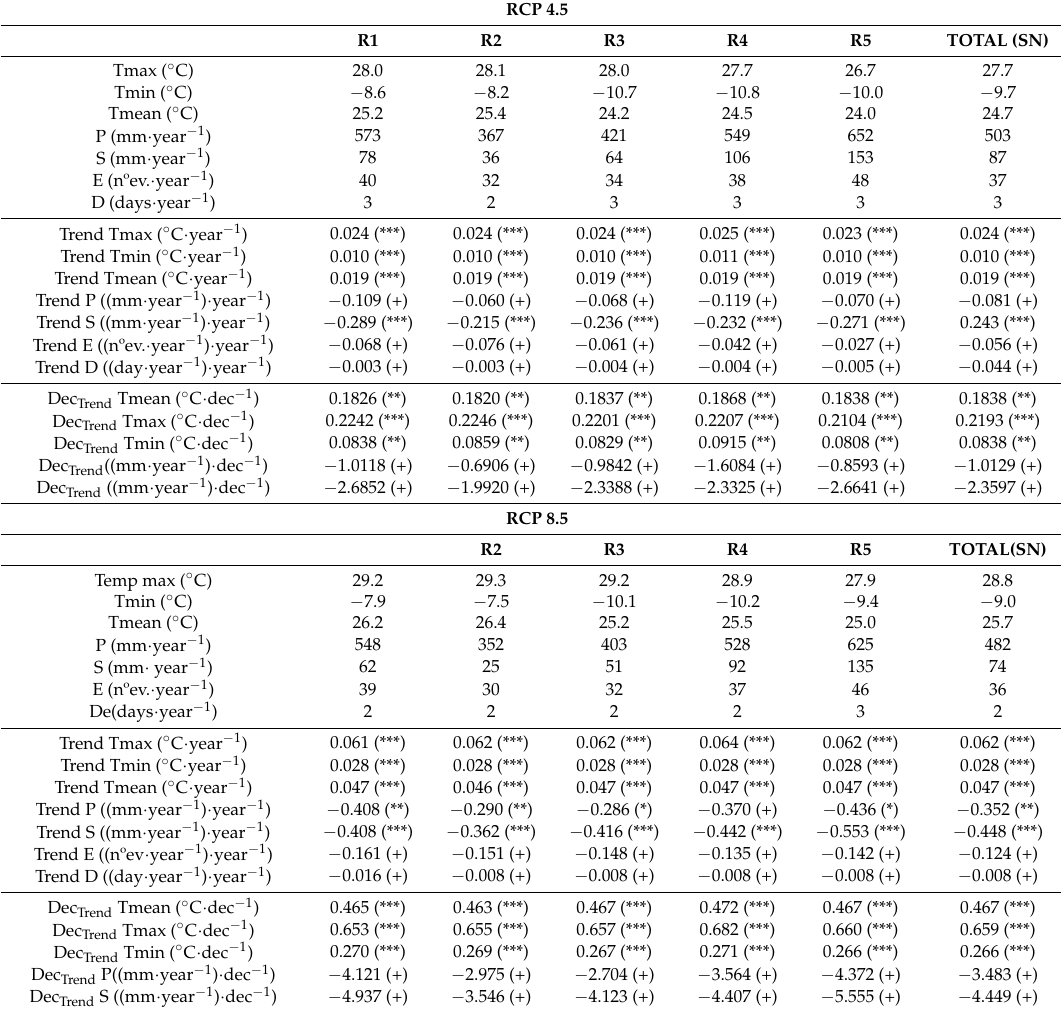
Table 2. Summary of the mean values of the study variables during the 2006–2100 study period under each scenario, averaged over each region (see Figure 1) in Sierra Nevada (R1 to R5) and the whole study area (SN), together with the associated mean annual trends. The trend analysis results are defined according to the Mann-Kendall test as having either (1) excellent significance, 99% (***); (2) good significance, 95% (**); (3) acceptable significance, >90% (*); and (4) no significance, less than 90%